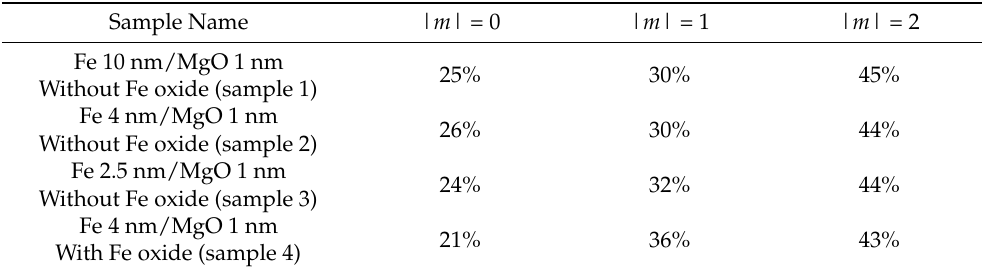
Table 2. Occupation number of magnetic quantum numbers obtained by magnetic Compton profile measurements. Notice that | m | = 1 states have two states of m = ±1, and | m | = 2 states m = ±2.